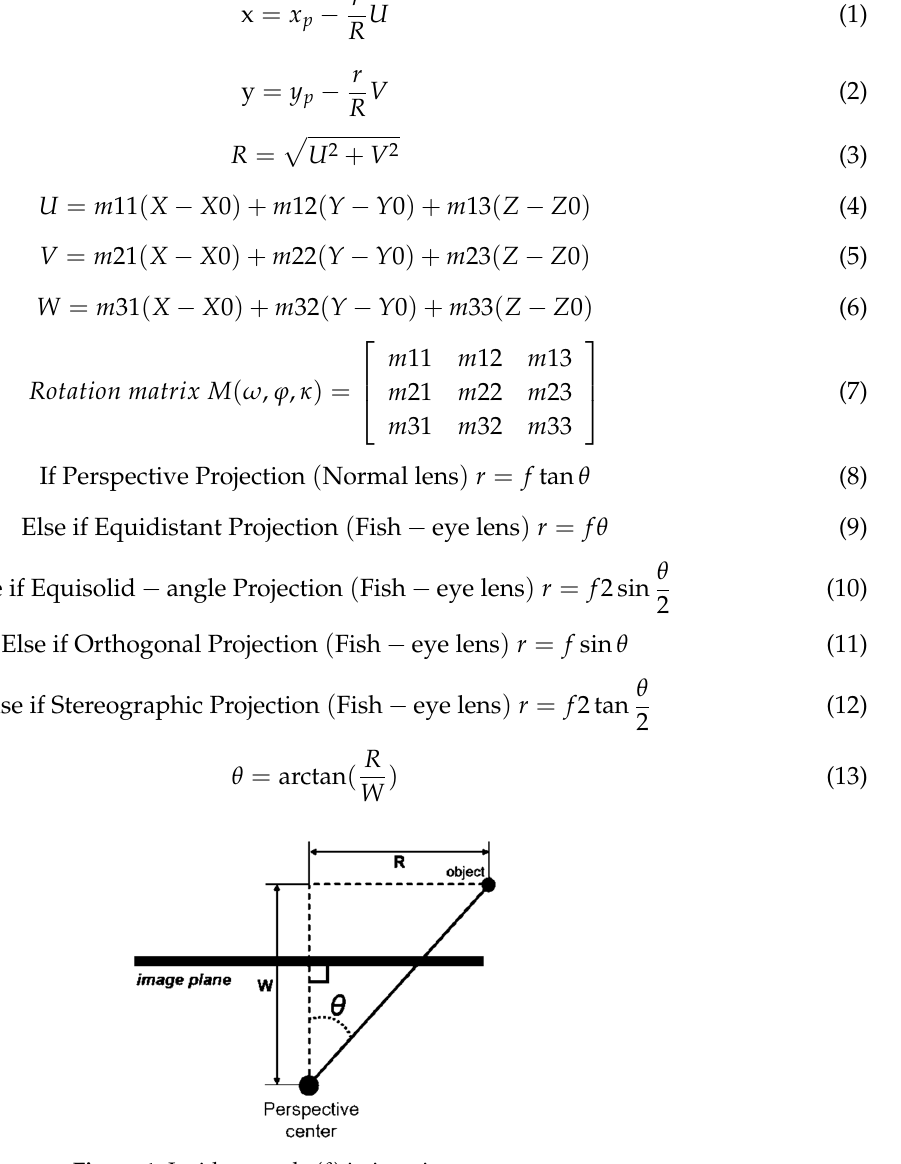
Figure 1. Incident angle ( θ ) in imaging geometry